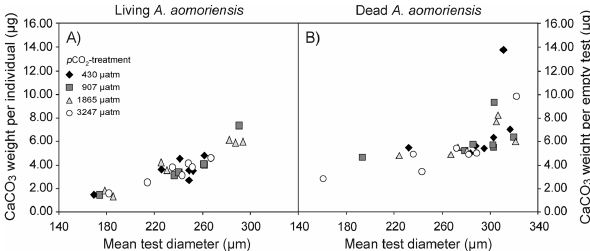
Fig. 5. Mean of total CaCO 3 weight of (A) living specimens in- cluding cytoplasm and (B) empty test of A. aomoriensis in relation to mean test diameter for the four tested p CO 2 treatments. Mean values refer to replicate